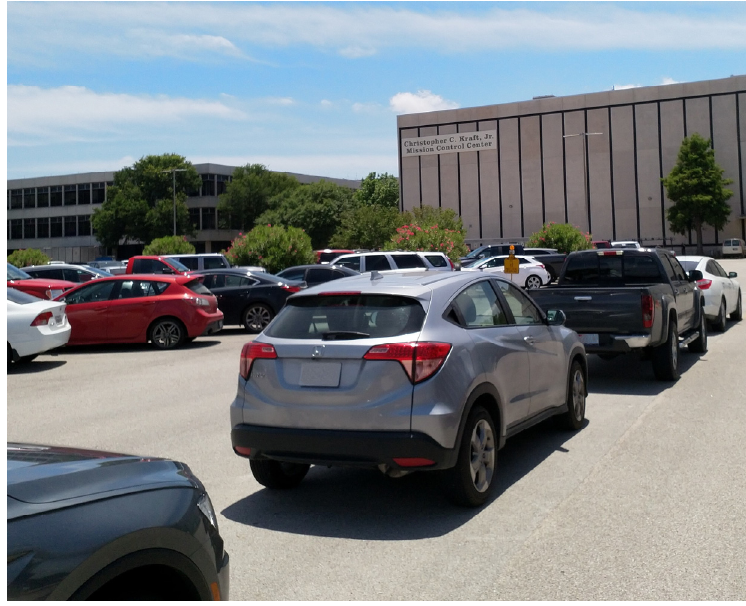
Figure 7. Example of parking conditions in a public parking lot.